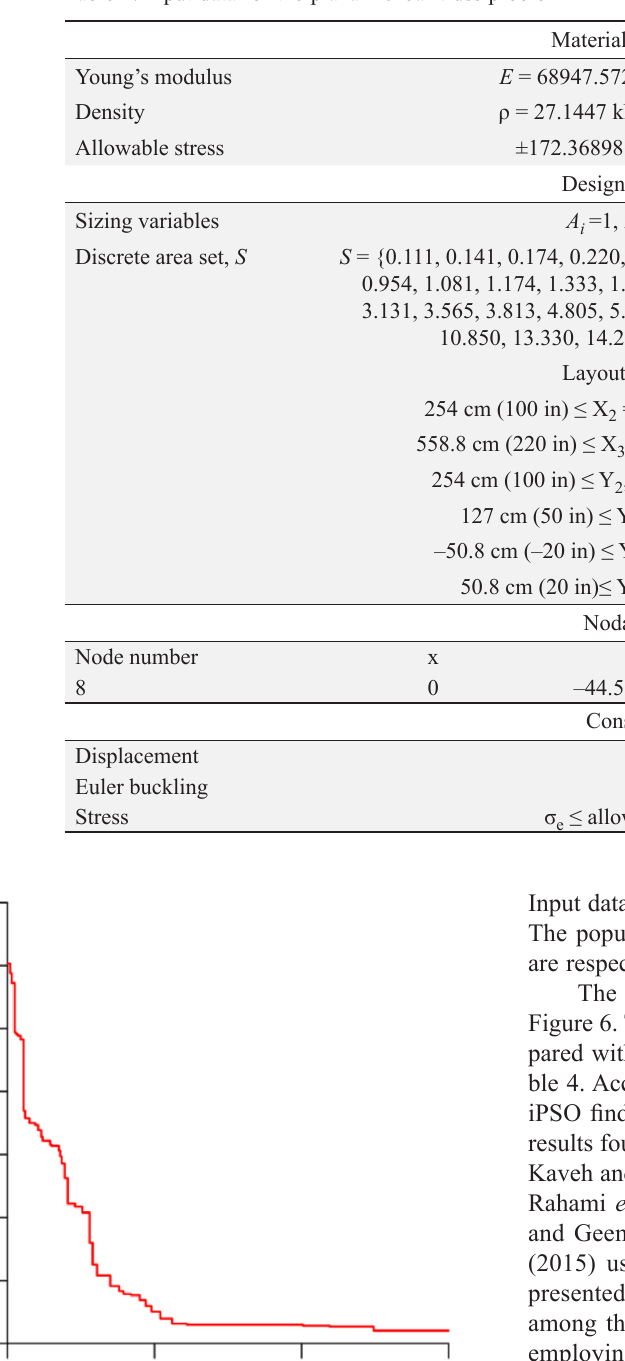
Table 1. Input data for the planar 15-bar truss problem